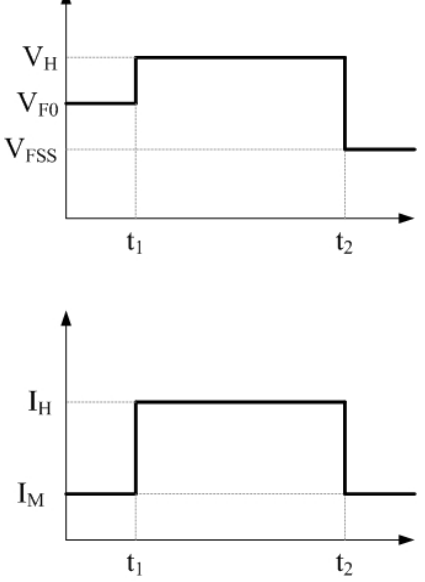
Figure 2. Measuring procedure of thermal resistance measurement